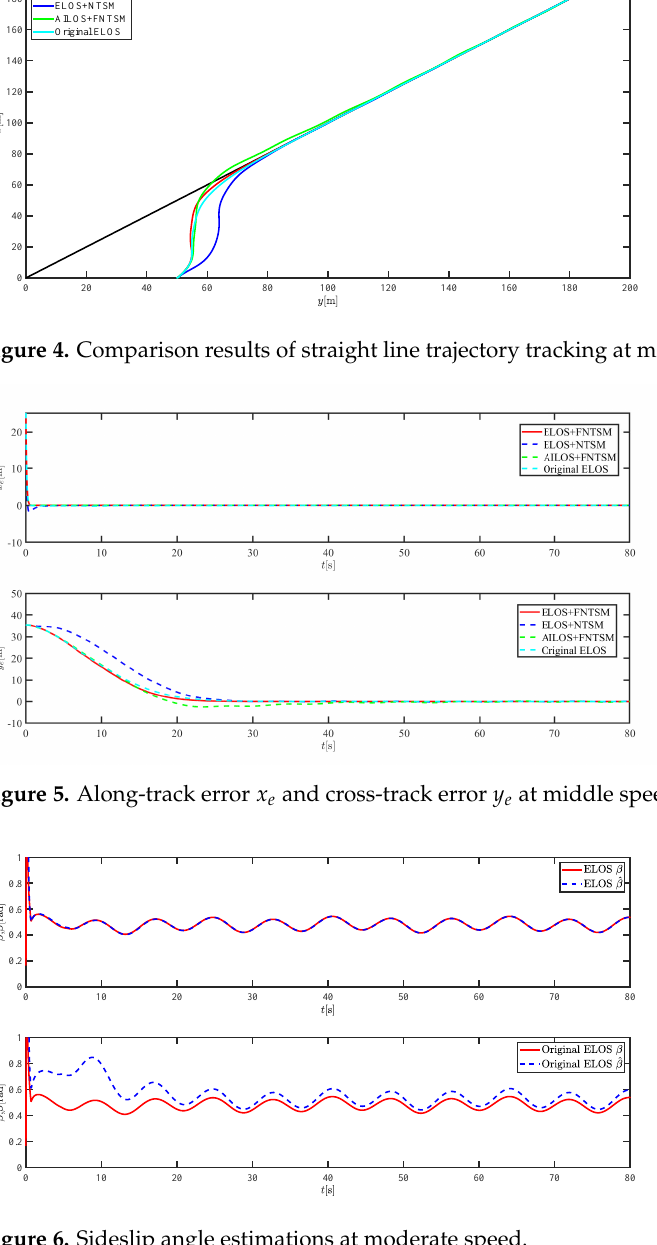
Figure 6. Sideslip angle estimations at moderate